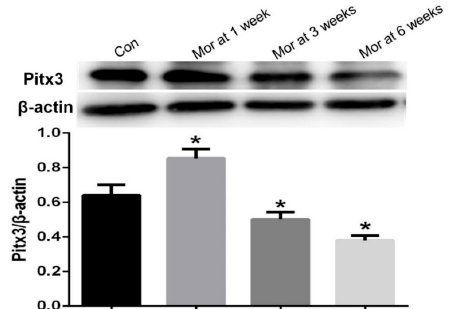
Figure 7. Western blot analysis of Pitx3 expression in the VTA. The relative level of Pitx3 was significantly up-regulated after one week of morphine dependence ( P < 0.05). However,